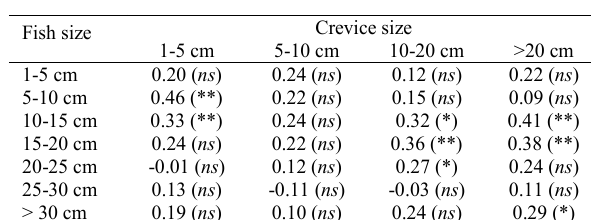
Table 6. Pearson’s correlation results (r and p values) on the relationship between fish and crevice sizes. *: significant